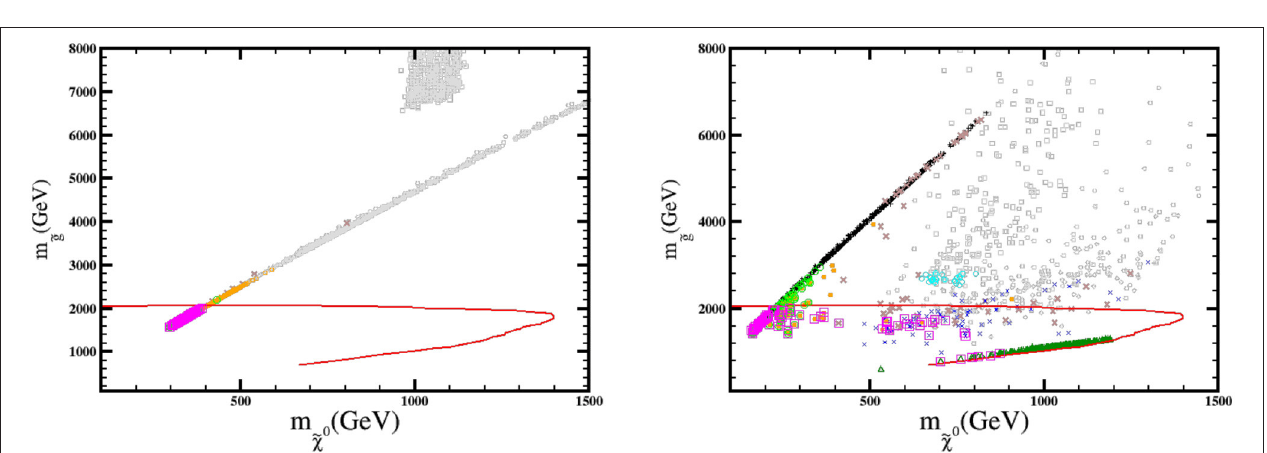
FIGURE 4 | As in Figure 3 for the m